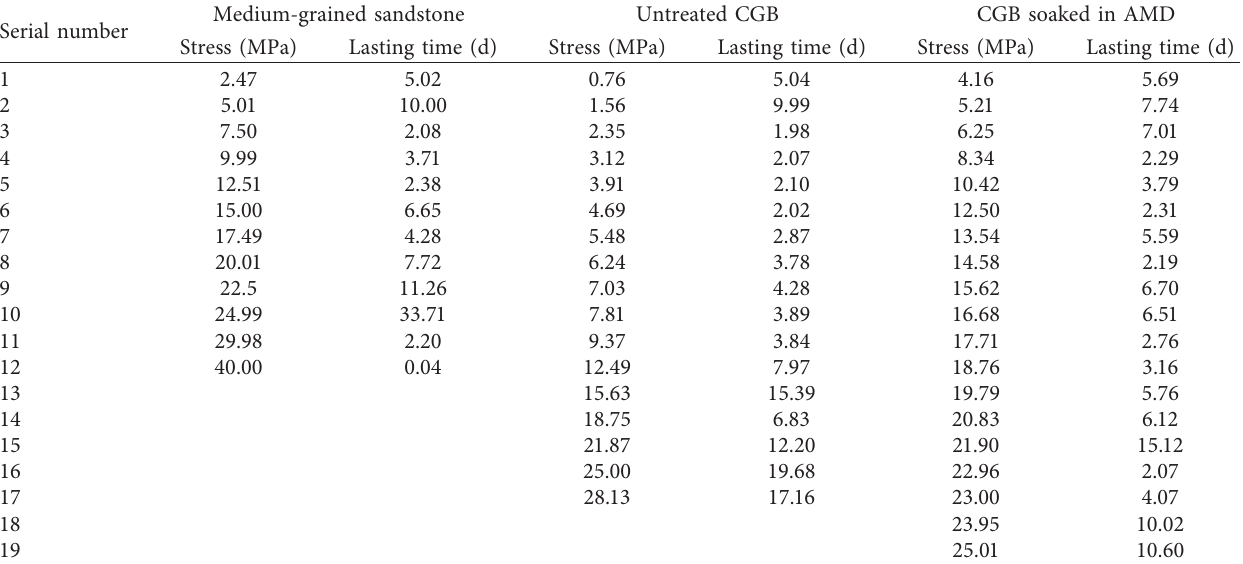
Table 10: Loading stages of given specimens.